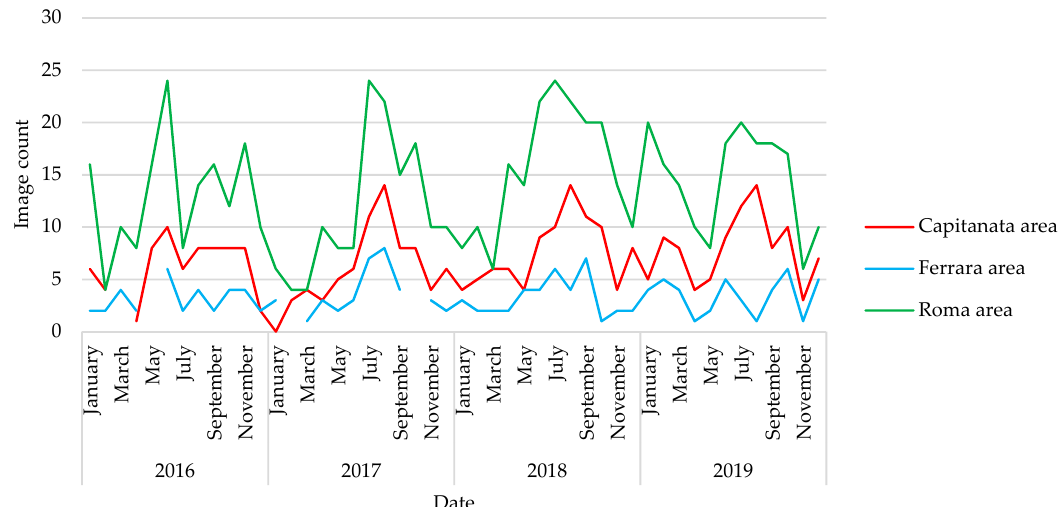
Figure 3. Amount of cloud free Sentinel-2 scenes available, monthly, for the three study areas (Capitanata, Ferrara, and Rome) over the period (2016–2019). The total number of pixels is equal to 63578610, 171400476, and 30214976 for the regions Ferrara, Rome, and Capitanata, respectively.